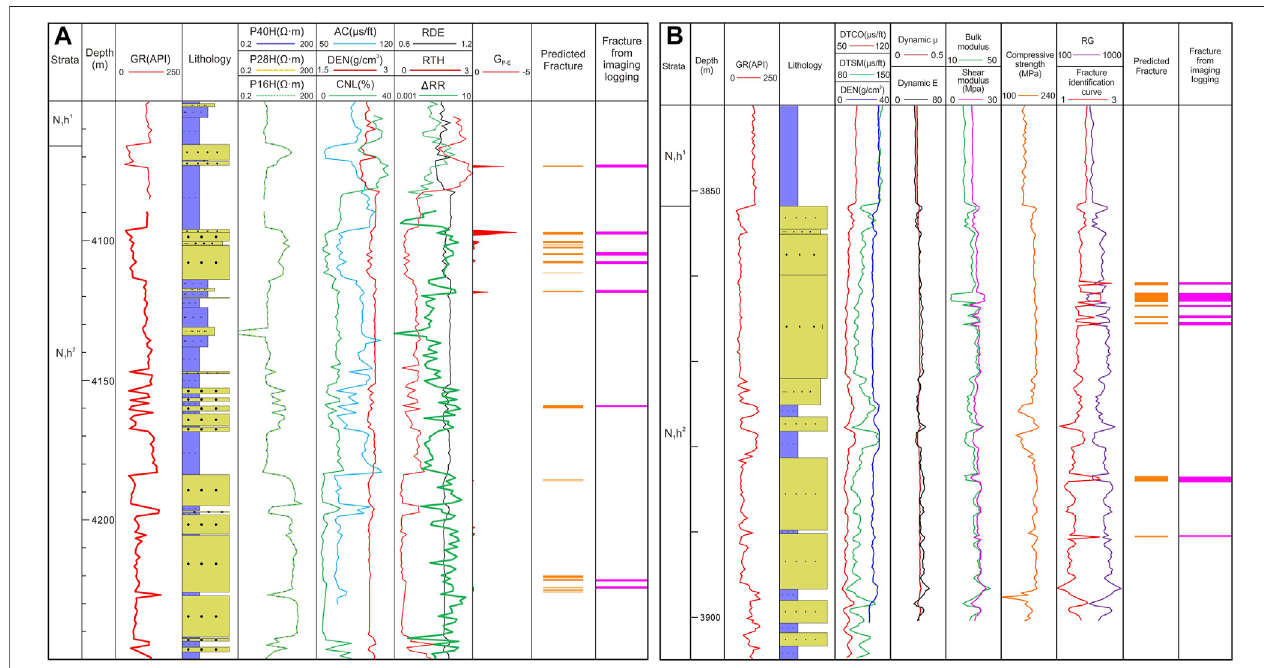
FIGURE 10 | Comparison of fracture identi fi cation result from conventional logging and the fractures identi fi ed from imaging logging. (A) Identi fi ed fractures based on the multivariate discriminant method in well LD-A-1-6, and (B) the fracture identi fi cation result by the identi fi cation method based on rock integrity evaluation in well